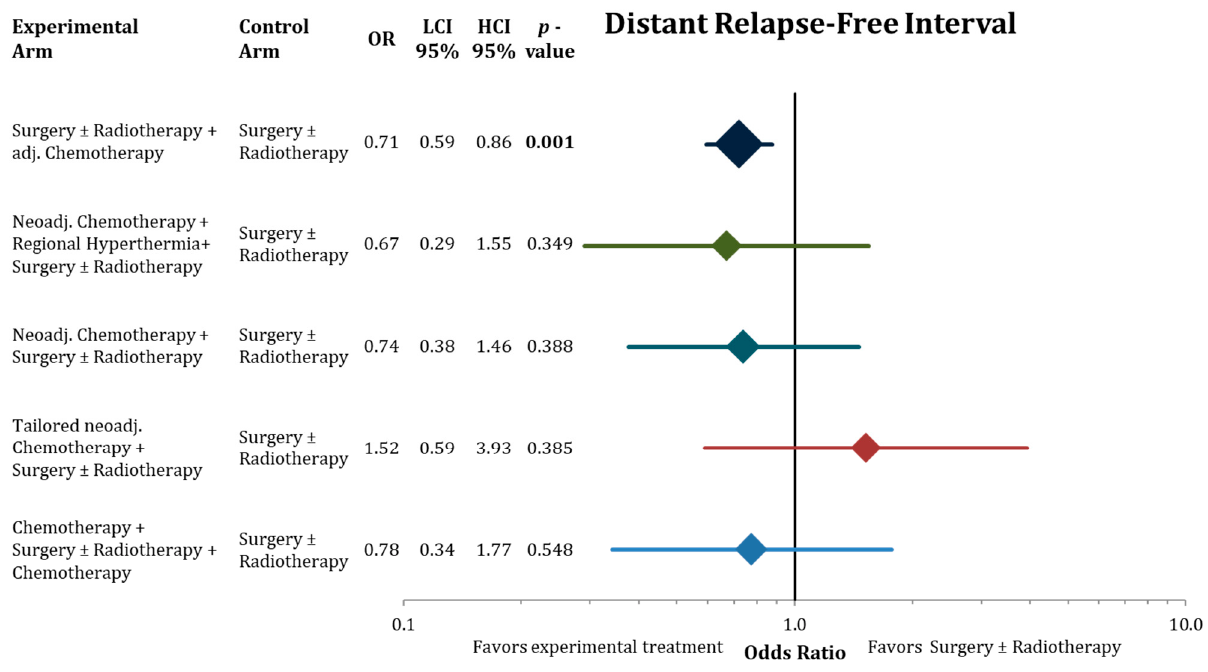
Figure 5. Forest plot comparing local relapse-free interval in the network analysis of the experimental treatments against surgery ± radiation therapy. Hazard ratios with lower and upper 95% confidence intervals and the corresponding p -values are presented. The sizes of the diamonds are proportional to the weights in the meta-analysis. HR = hazard ratio, LCI = low limit of 95% confidence interval, and HCI = high limit of 95% confidence interval. Bold values indicate significant p -values.